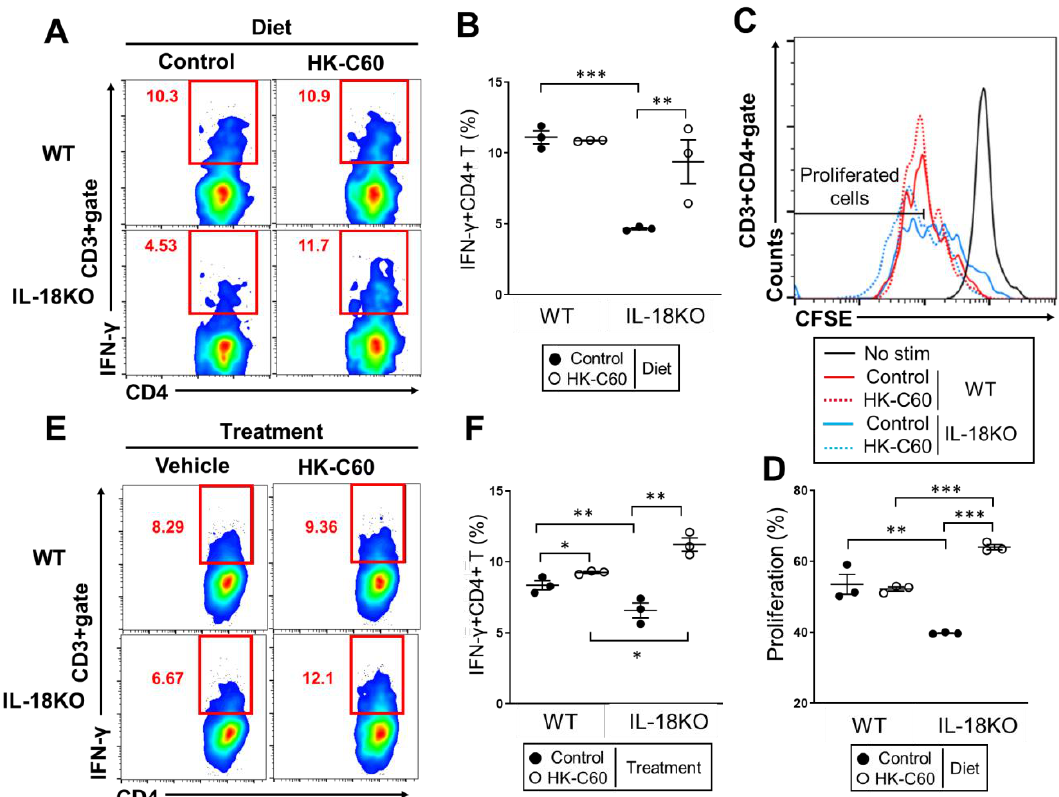
Figure 3. TCR-dependent CD4+ T cells activity is enhanced in IL-18-deficient PP by exposing with HK-C60. ( A – D ) In vitro stimulation of PP isolated cells. The cells were isolated from PPs of aged mice fed with HK-C60 or control diet. The cells were stimulated with anti-CD3/CD28 mAb at 37 °C for 48 h. ( A - B ) IFN-γ+CD4+ T (Th1) cell population in the culture. The cultured PP cells were re-stimulated with PMA/Ionomycin combined with GolgiStop TM at the last 5 h of culture. The representative image and percentage of Th1 cell population in CD3+gate are shown as ( A ) and ( B ) respectively. ( C – D ) The proliferation of CD4+ T cells in the culture. The cells were stained with CFSE prior seeding on the plate. The proliferated CD4+ T cells were analyzed by flow cytometry. The representative image of CD4+ T cells proliferation and the percentage of proliferated cell in CD3+CD4+gate are shown as ( C ) and ( D ) respectively. ( E – F ) Ex vivo stimulation of PP isolated cells. The cells were isolated from PPs of aged mice with normal diet. The cells were stimulated with anti-CD3/CD28 mAb and were further treated with HK-C60 or vehicle control. The culture was incubated at 37 °C for 48 h. At the last 5h, the cells were re-stimulated with PMA/Ionomycin combined with GolgiStop TM . The IFN-γ+CD4+ T (Th1) cells were analyzed by flow cytometry. The representative image and percentage of Th1 cell population in CD3+gate are shown as ( E ) and ( F ) respectively. The data were shown as the representative or mean ± SEM of six samples in three independent experiments. Each dot indicates the data from one sample. A Mann–Whitney U test was used to analyze data for significant differences. Values of * p < 0.05, ** p < 0.01, and *** p < 0.001 were regarded as significant.